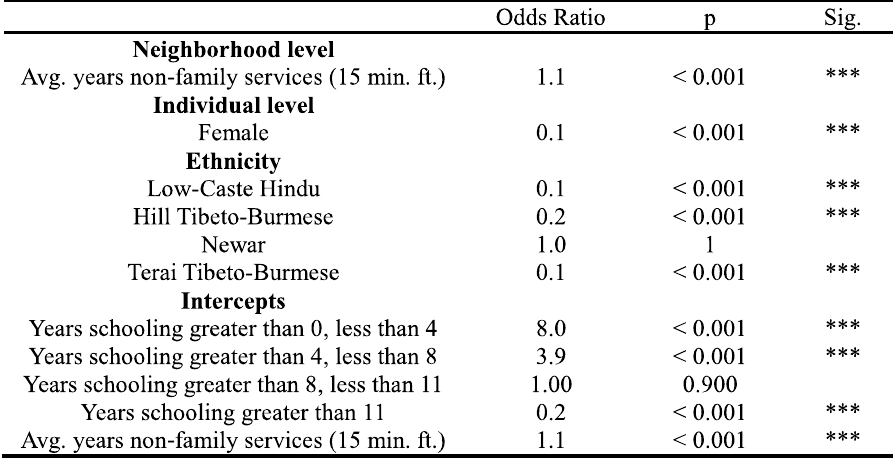
Table A1.5: Education model used in the Chitwan ABM. The model is derived from analysis of a sample of CVFS data including all individuals aged 25-30 in 1996. Odds- ratios are from an ordinal logistic regression predicting education level as 0, 0-4, 4-8, 4-11 or >11 years. P-values are two-sided. Significance is coded as: for P < 0.1, * for P < .05, ** for P < 0.01, *** for P < 0.001. n=715, pseudo R 2 =.435. The odds-ratios for ethnicity are relative to Upper-caste